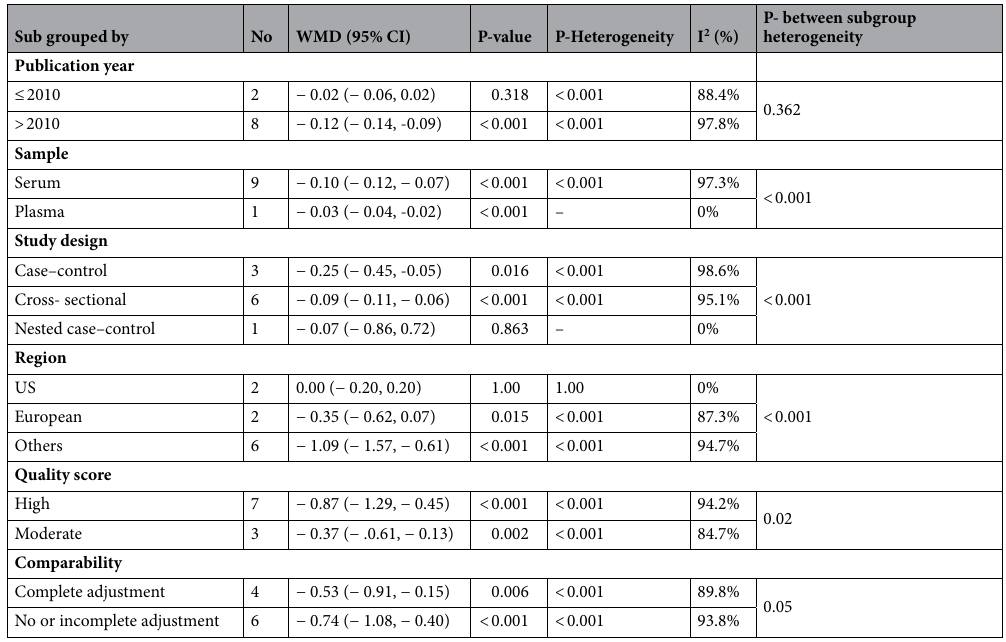
Table 3. Subgroup analysis to assess the magnesium concentrations in subjects with prediabetes. WMD weighted mean